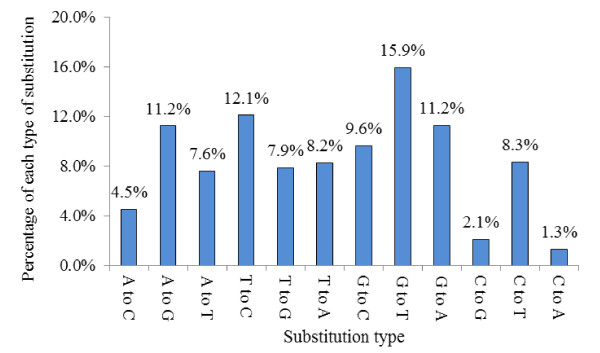
Histogram displaying the single nucleotide mismatches in the miRNAs seed region sequence when aligning un-annotated sRNAs tags with mature miRNAs from miRBase19.0. The axis represents the percentage comparing of the observed count of each type to the total count of all of substitution type. Substitutions listed on the abscissa are from DNA (genome) to RNA (small RNA sequence).